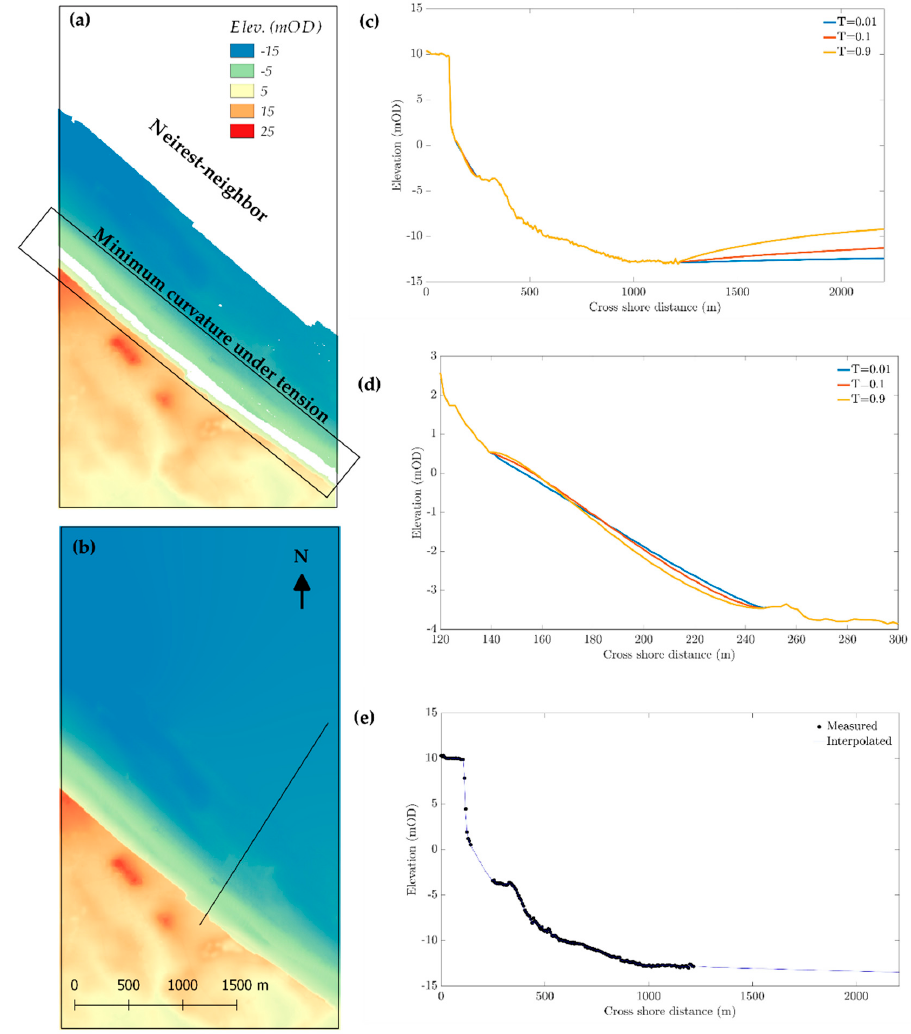
Figure 7. DTM of study site: ( a ) EA-LIDAR inland topography year 1999 and EA-multibeam bathymetry year 2011 (white areas indicate data gaps); ( b ) interpolated DTM used in this work; ( c ) comparison of elevations along the transect shown by a solid black line in ( b ) using different tension parameter values (i.e., notice the unrealistic depth decrease seawards of ca. 1250 m cross-shore location); ( d ) detail of the upper shore-face interpolated bathymetries for different tension parameter values; ( e ) the final interpolated elevation along the same transect.